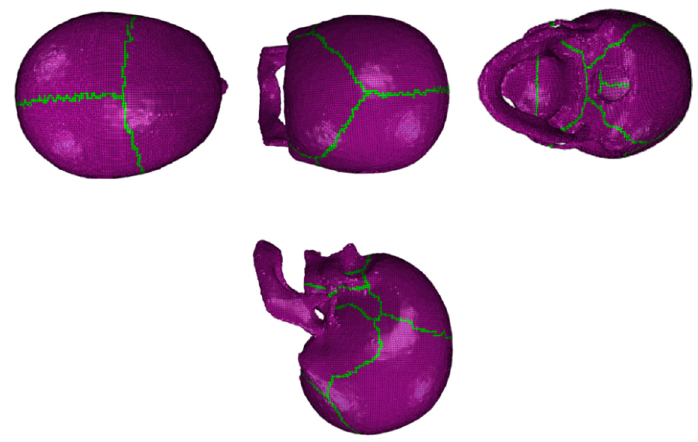
Figure 2. Visualization of the final complete model in Abaqus with trabecular bone, cortical bone (1.5 mm), and cranial sutures.